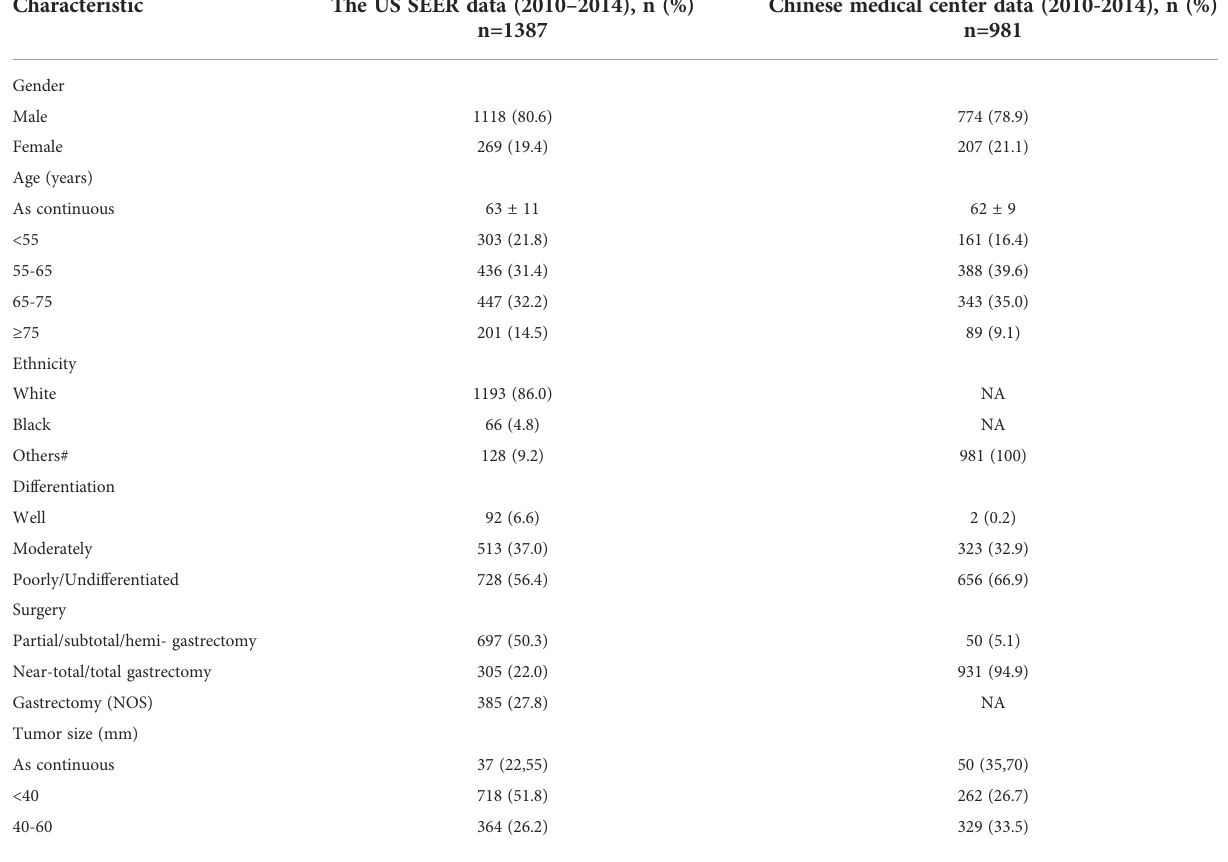
TABLE 2 Baseline clinicopathological